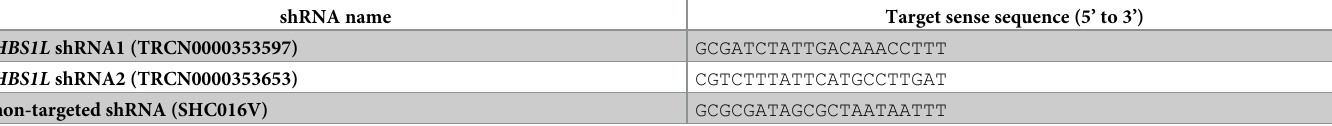
Table 1. The table demonstrates the target sequence of HBS1L shRNAs and non-targeted shRNA